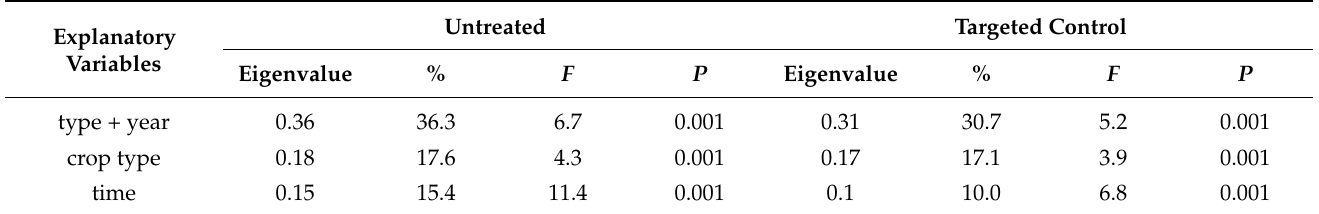
Table 5. Net effects of explanatory variables on the weed species composition in Pernolec for multi- crop rotation. Partial RDAs were used when gradient length < 3.0. Eigenvalue = sum of all canonical eigenvalues; % = percentage of explained variance; F = ratio for the test of significance of all canonical axes and p -value = the corresponding probability from the Monte-Carlo permutation test.